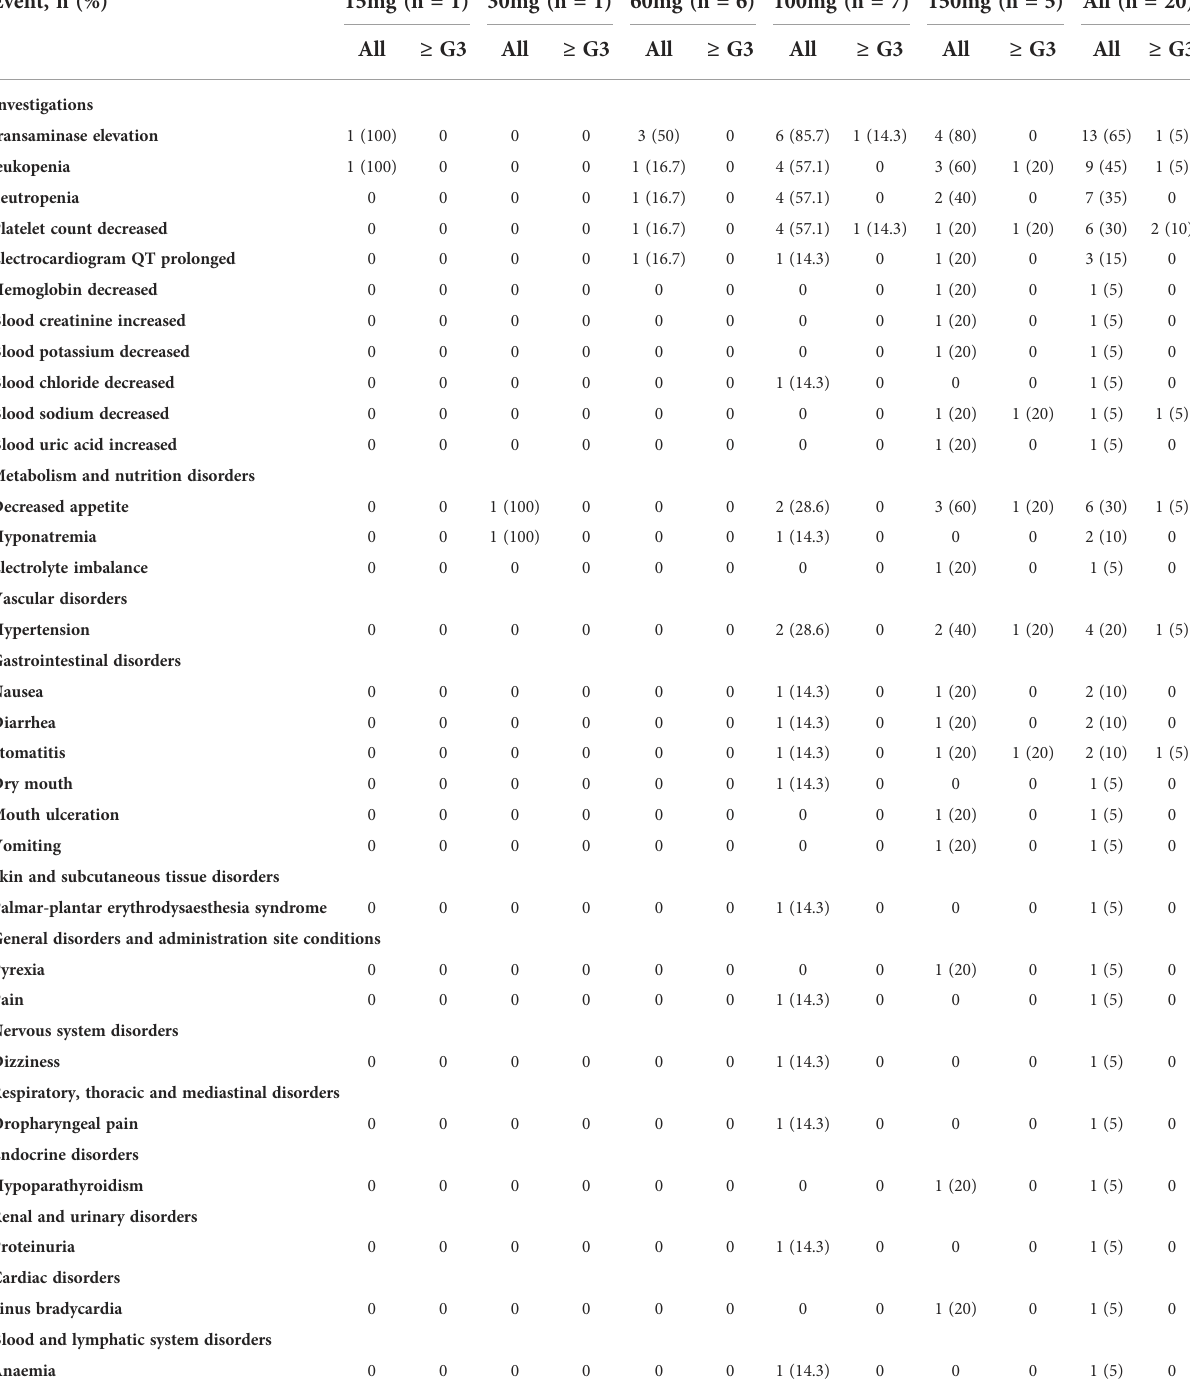
TABLE 2 Treatment-related adverse events reported in all patients. Event, n